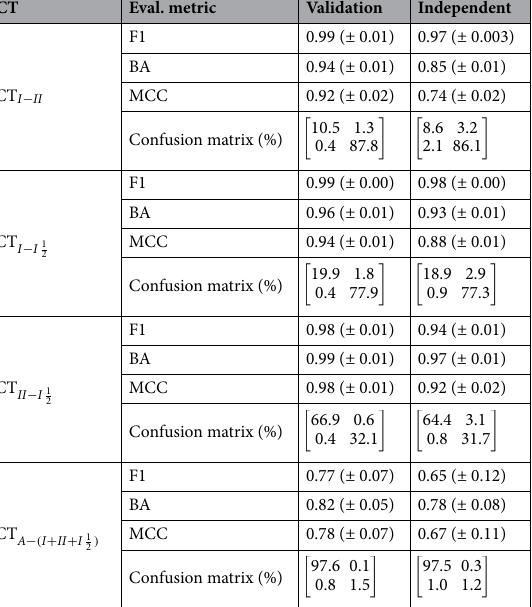
Table 2 shows the final results for the validation and independent test sets for different classification tasks. The values represent the averages over the 10 validation experiments. We used three metrics for evaluating the models: F1 measure, Mathews Correlation Coefficient (MCC), and Balanced Accuracy (BA). From the results in Table 2, we can see that the predictive models in the classification tasks for non-allosteric inhibitors always showed high accuracy. The F1 measure was between 0.94 and 0.98 showing a high ability in identifying the positive classes which were types I and II, in non-allosteric tasks. For CT II